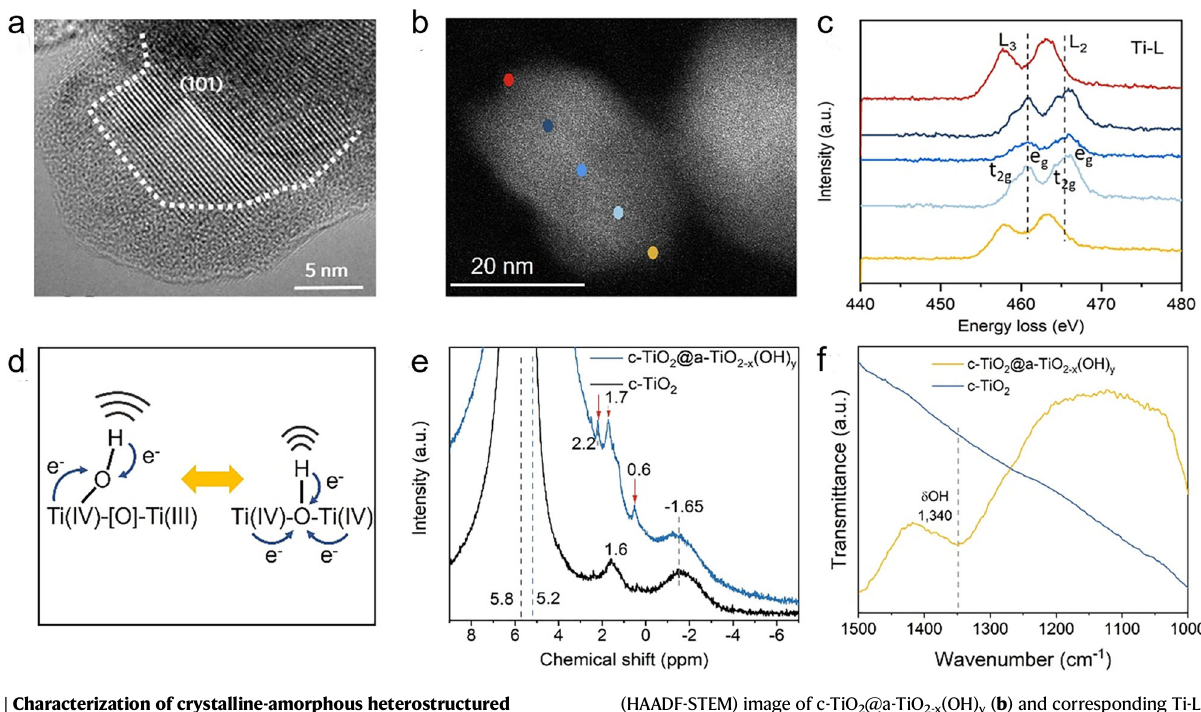
(HAADF-STEM) image of c-TiO 2 @a-TiO 2-x (OH) y ( b ) and corresponding Ti-L edge EELSspectraatdifferentpositions( c ). d Comparisonofgeometricalandelectronic structures between bridging and terminal hydroxyl . e , f 1 H MAS-NMR ( e ) and ATR- FTIR ( f ) spectra of c-TiO 2 @a-TiO 2-x (OH) y and c-TiO 2